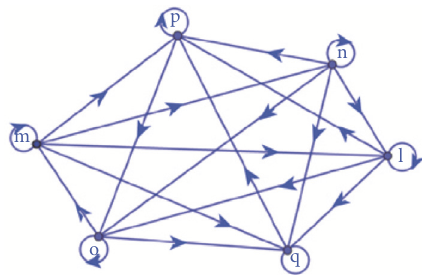
Figure 1: Graph depicting 𝐺𝑏𝑀𝑆